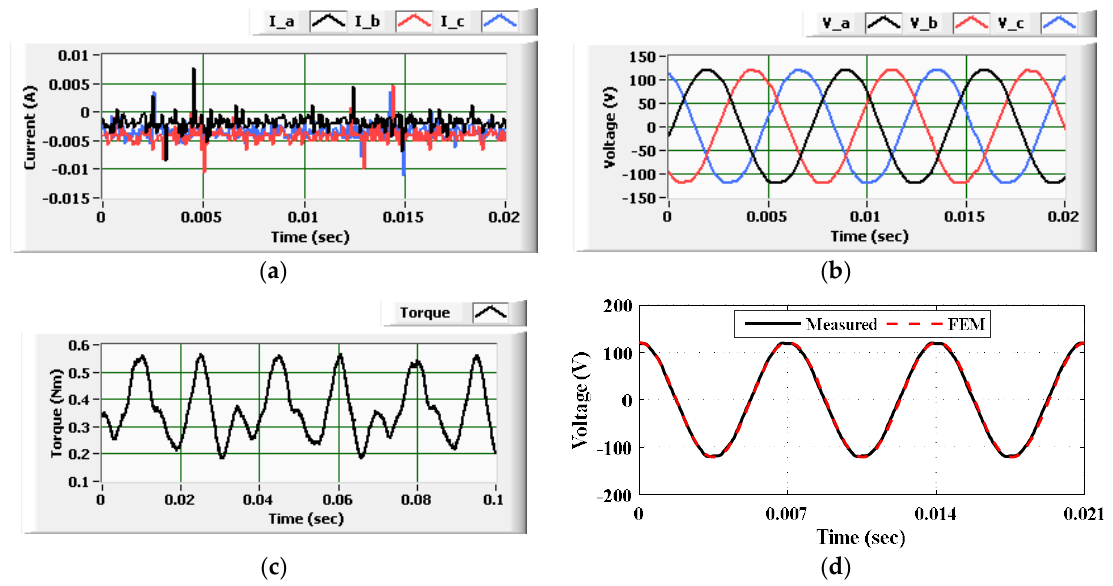
Figure 13. The experimental results at no-load as a generator. ( a ) The waveform of phases’ currents; ( b ) the waveform of phases’ voltages; ( c ) the electromagnetic torque; ( d ) the measured and FE-predicted phase voltage.